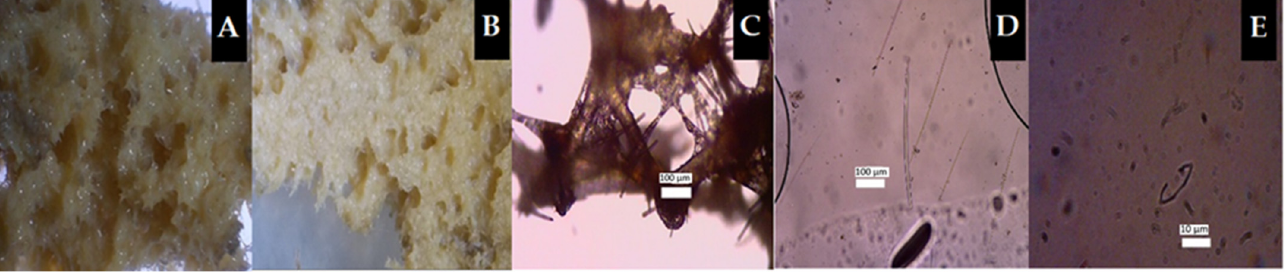
Figure 3. Morphology of the marine sponge Clathria (Thalysias) reinwardtii (Sp3): ( A ) consistency; ( B ) projection; ( C ) choanosome; ( D ) megasclere; ( E ) microsclera in the form of chelae (40 ×).